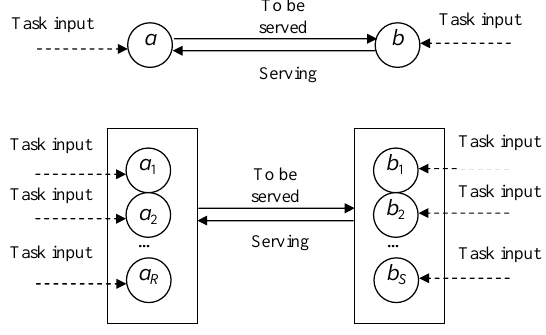
Fig. 8. Interaction chain of a served agent and a serving agent (above) and interaction chain of served agents and serving agents (under).